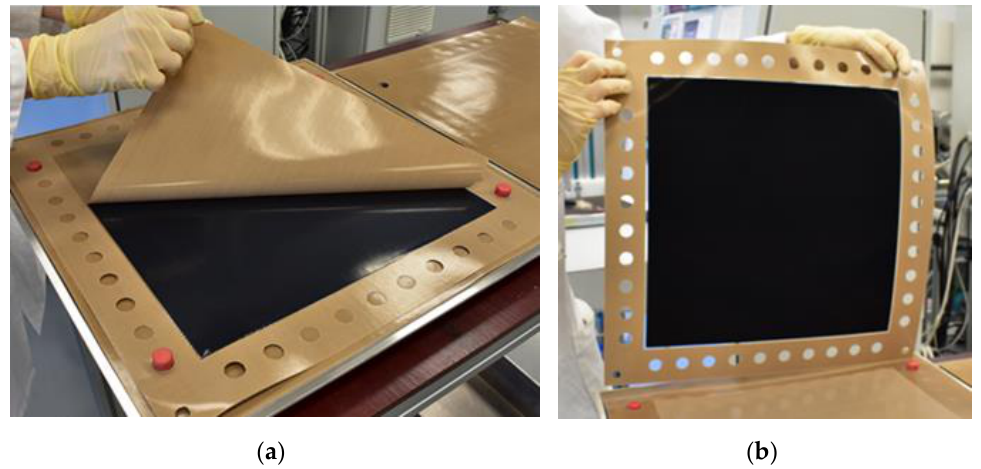
Figure 4. ( a ): After assembly, the substrate could be removed from the electrode; ( b ): A complete and isolated MEA.